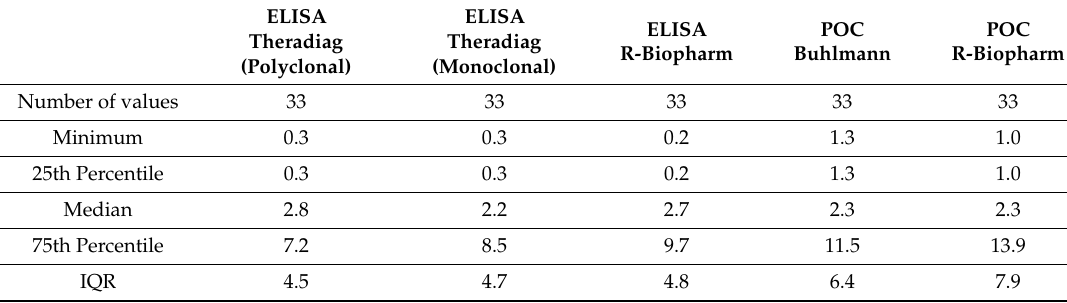
Table 4. Median and interquartile ranges (IQR, µ g / mL) between assays. POC-Point of